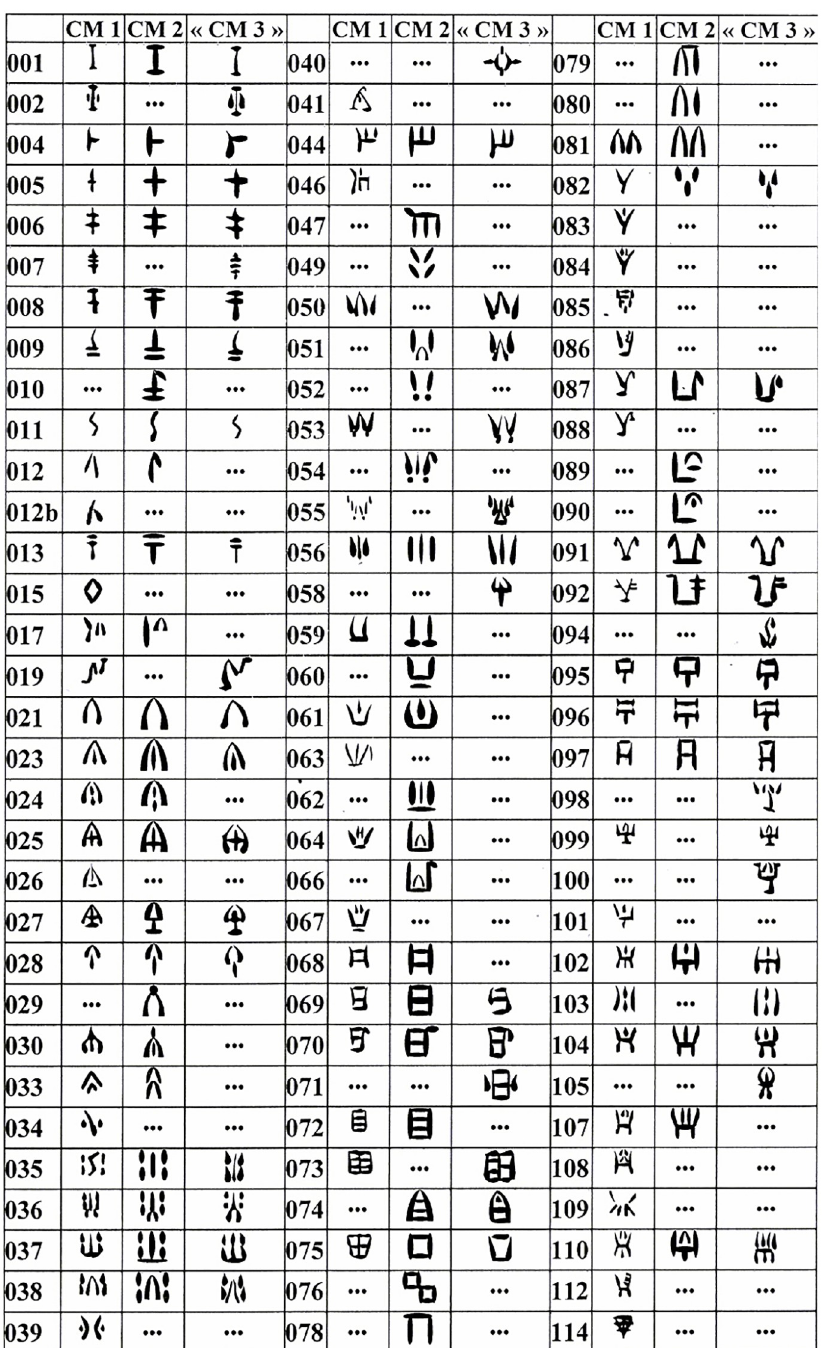
Fig 1. Repertoire of 96 Cypro-Minoan syllabograms and their classification in three sub-corpora according to Olivier [5].